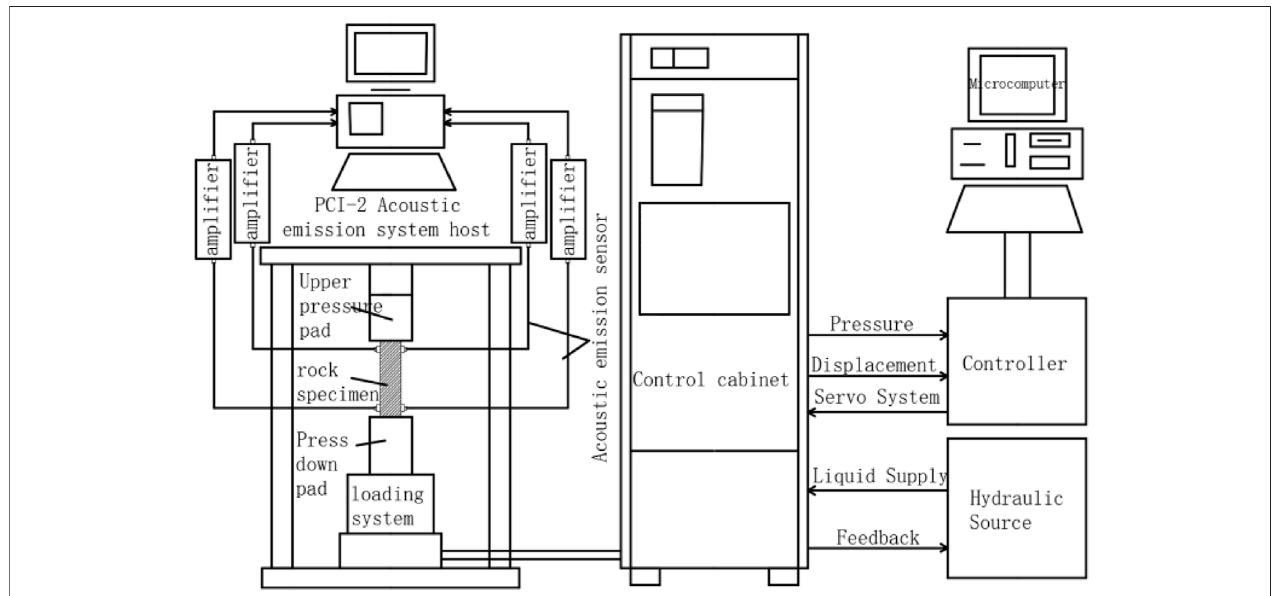
FIGURE 4 | Schematic diagram of the test equipment.